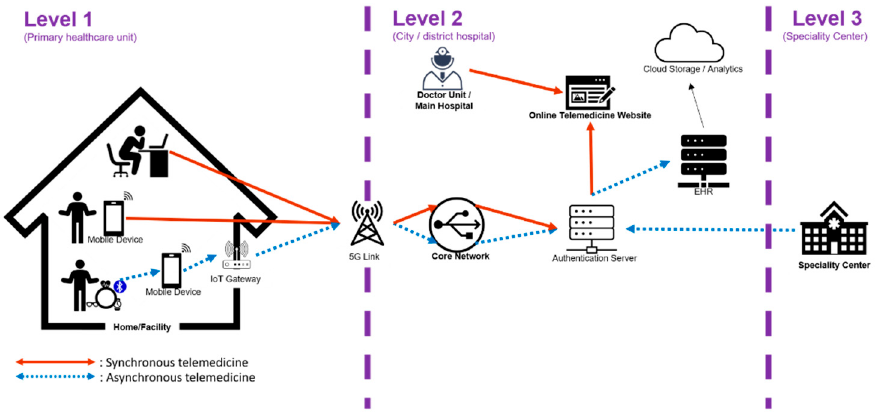
Figure 1. A general telemedicine system with asynchronous and synchronous